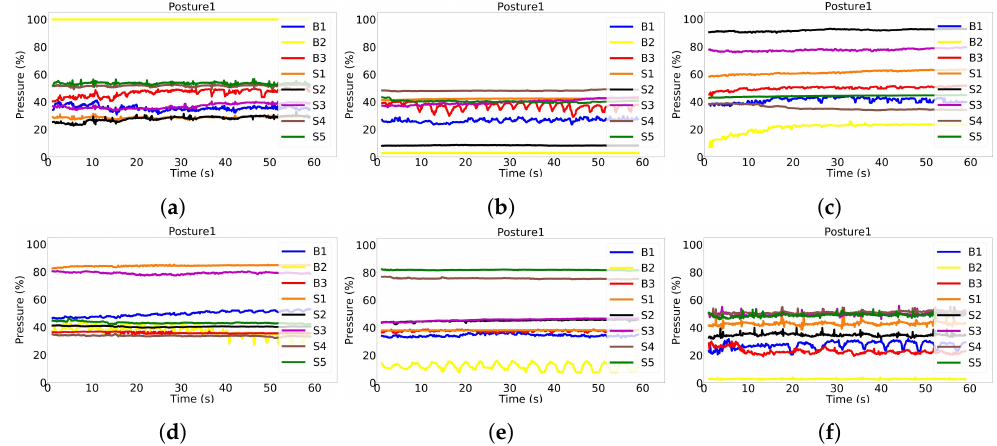
Figure 15. The raw signals of the pressure sensors as obtained from six different subjects sitting in Posture 1 are shown in ( a – f ). The weight distributions of the subjects on sensors have different patterns, challenging the models in recognizing them as the same posture.